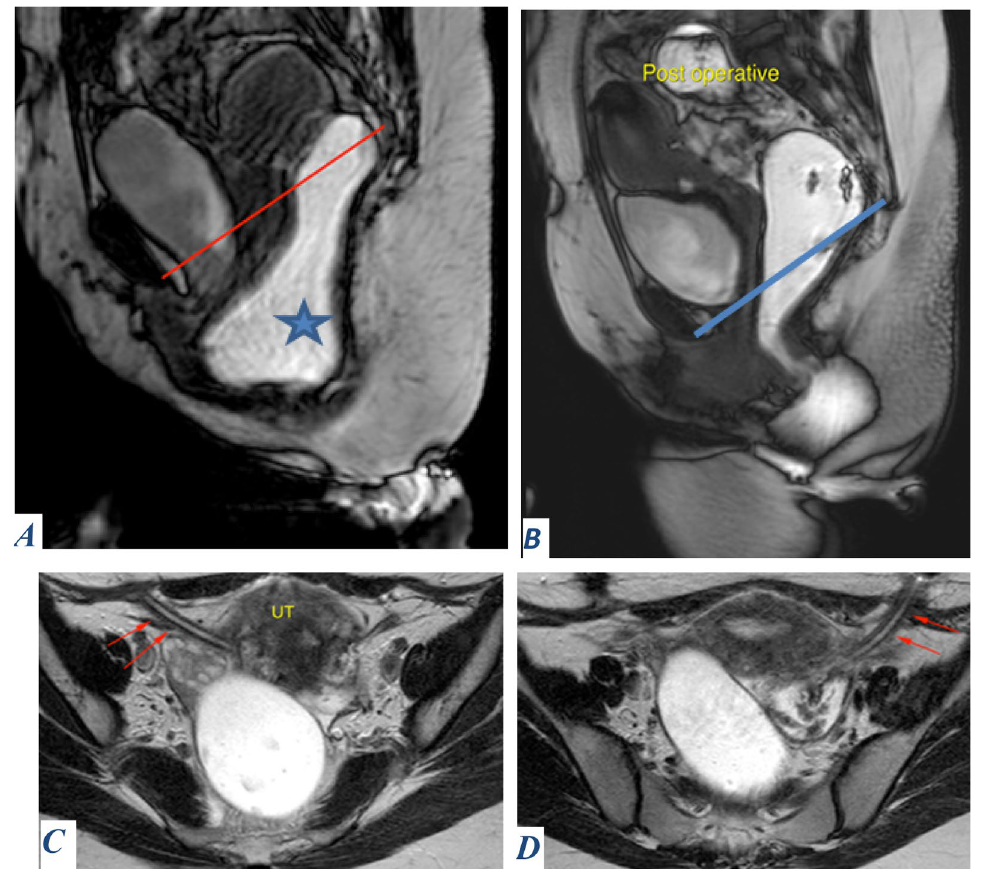
Fig. 2 A 48-year-old lady referred with symptoms of multi-compartmental pelvic floor descent. She underwent uterine mesh placement and had a successful outcome. A Sagittal BFFE MRD during evacuation shows mild uterine descent below PCL (red line) and a rectocele (blue star). B